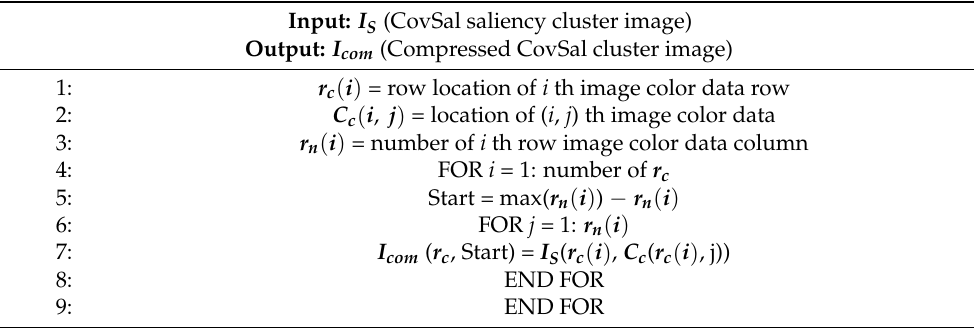
Table 1. CovSal cluster compressing